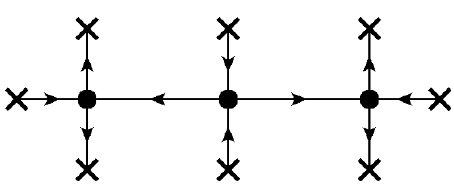
Figure 4 . The diagram corresponding to the invariant eq.